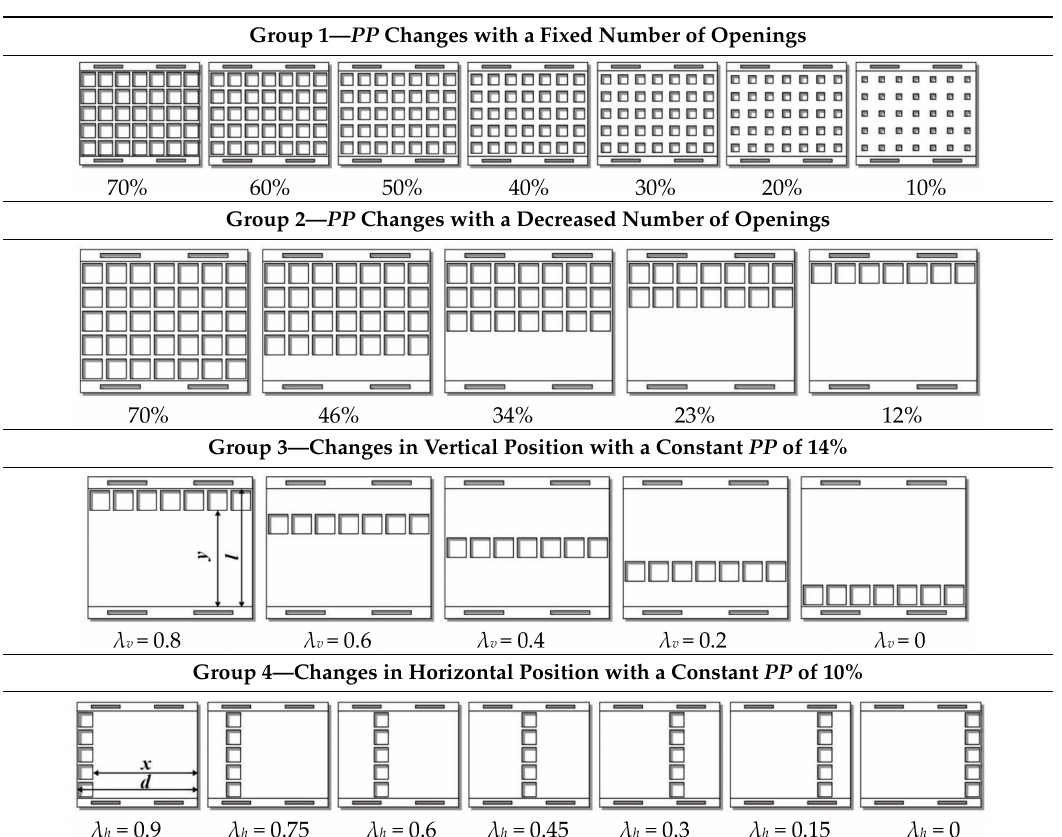
Table 1. Variations in the configuration of perforated mass